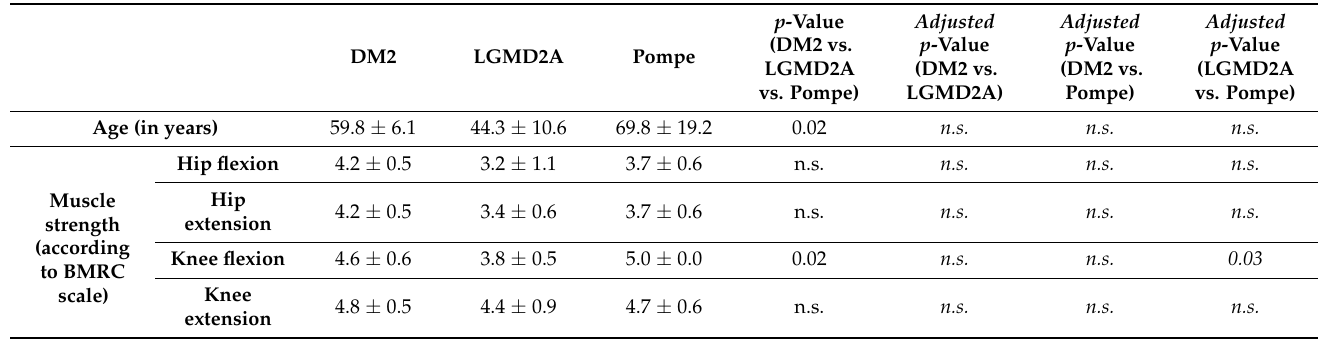
Table 3. Age and muscle strength. Table providing details on age and muscle strength for muscle groups responsible for hip flexion and extension or knee flexion and extension (according to clinical examination considering the British Medical Research Council (BMRC) scale). Values are provided separately for patients with myotonic dystrophy type 2 (DM2), limb girdle muscular dystrophy type 2A (LGMD2A), and Pompe disease and are displayed as mean ± standard deviation. P -values for the comparison of the three groups as well as adjusted p -values (derived from post-hoc testing, italics ) are shown (n.s.: not statistically significant, p > 0.05).